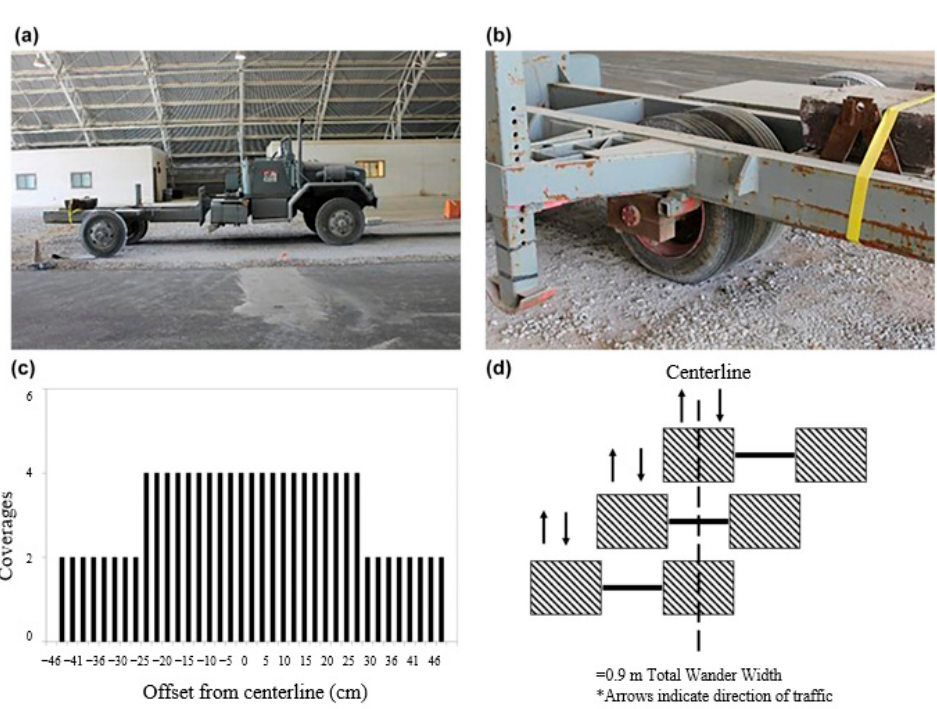
Figure 27. Traffic application equipment and traffic pattern: ( a ) overall view of load cart; ( b ) close-up of test gear configuration; ( c ) normally distributed pattern; ( d ) traffic application pattern [126].